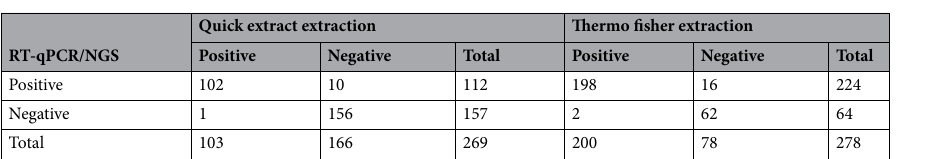
Table 1. Contingency table showing results in absolute count for each extraction method. Rows are actual RT-PCR results and columns are NGS